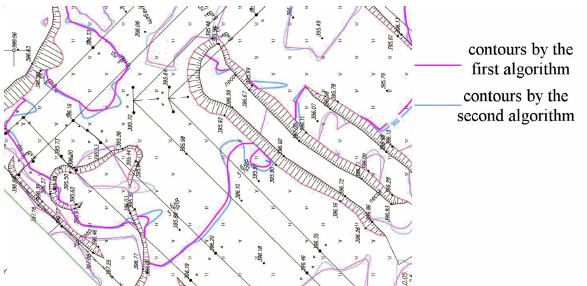
Figure 10 . The comparison of generating contours using different algorithm.